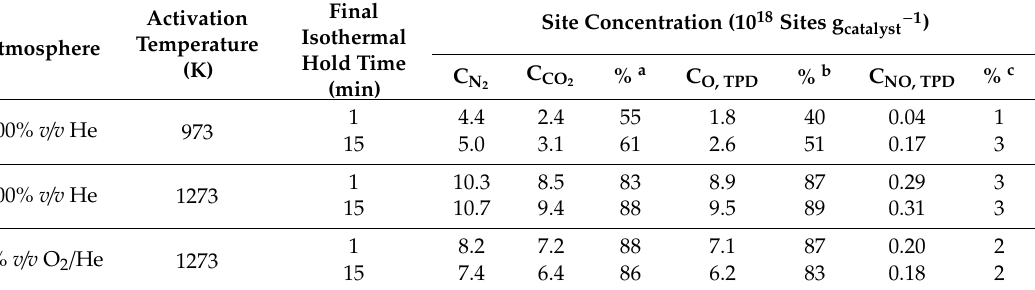
Table 2. Activation conditions and concentration of active sites for FeZSM-5 2300Fe